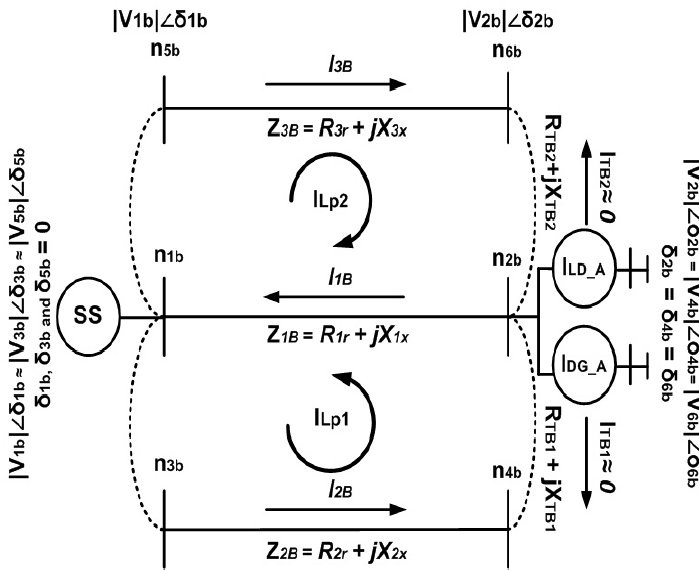
Figure 2. Equivalent mesh distribution network (MDN) model with tie and loop currents reduction aiming at loss minimization condition ( LMC ) [30,31].